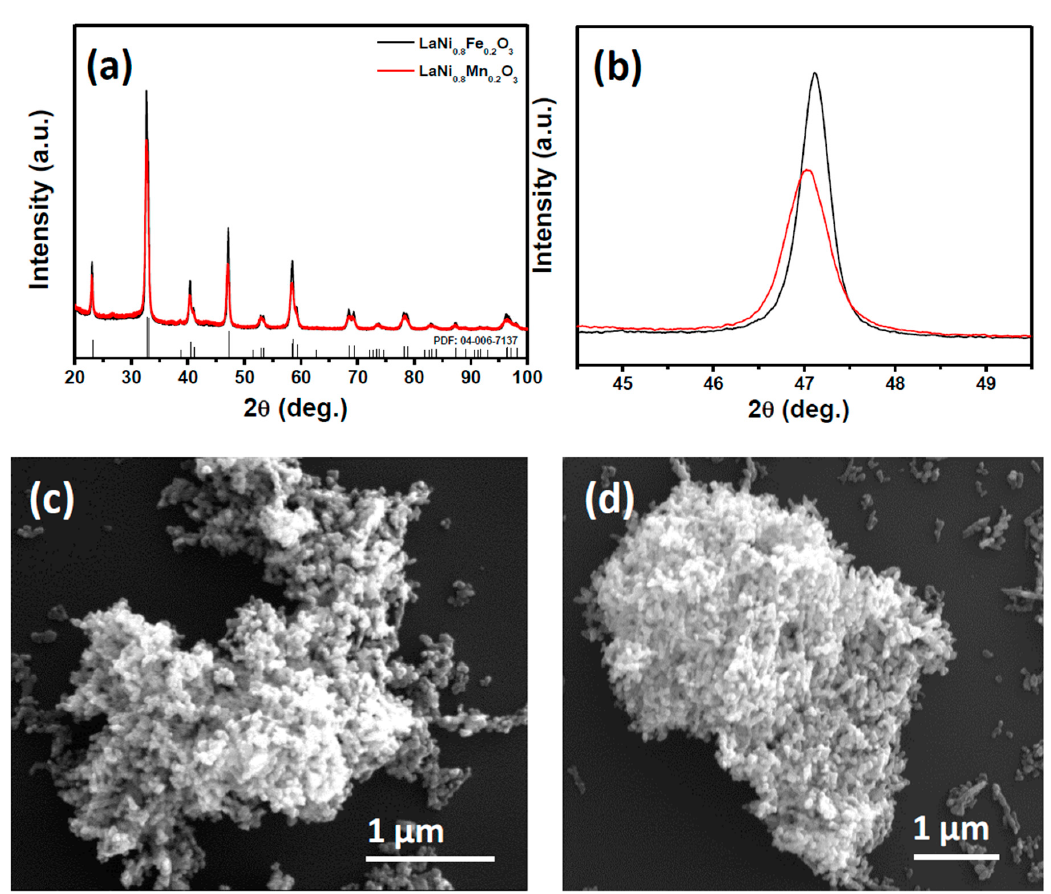
Figure 1. ( a ) XRD pattern of as-synthesized LaNi 0.8 Fe 0.2 O 3 and LaNi 0.8 Mn 0.2 O 3 perovskites; ( b ) (200) reflection; SEM images of as-synthesized; ( c ) LaNi 0.8 Fe 0.2 O 3 ; and ( d ) LaNi 0.8 Mn 0.2 O 3 perovskites.